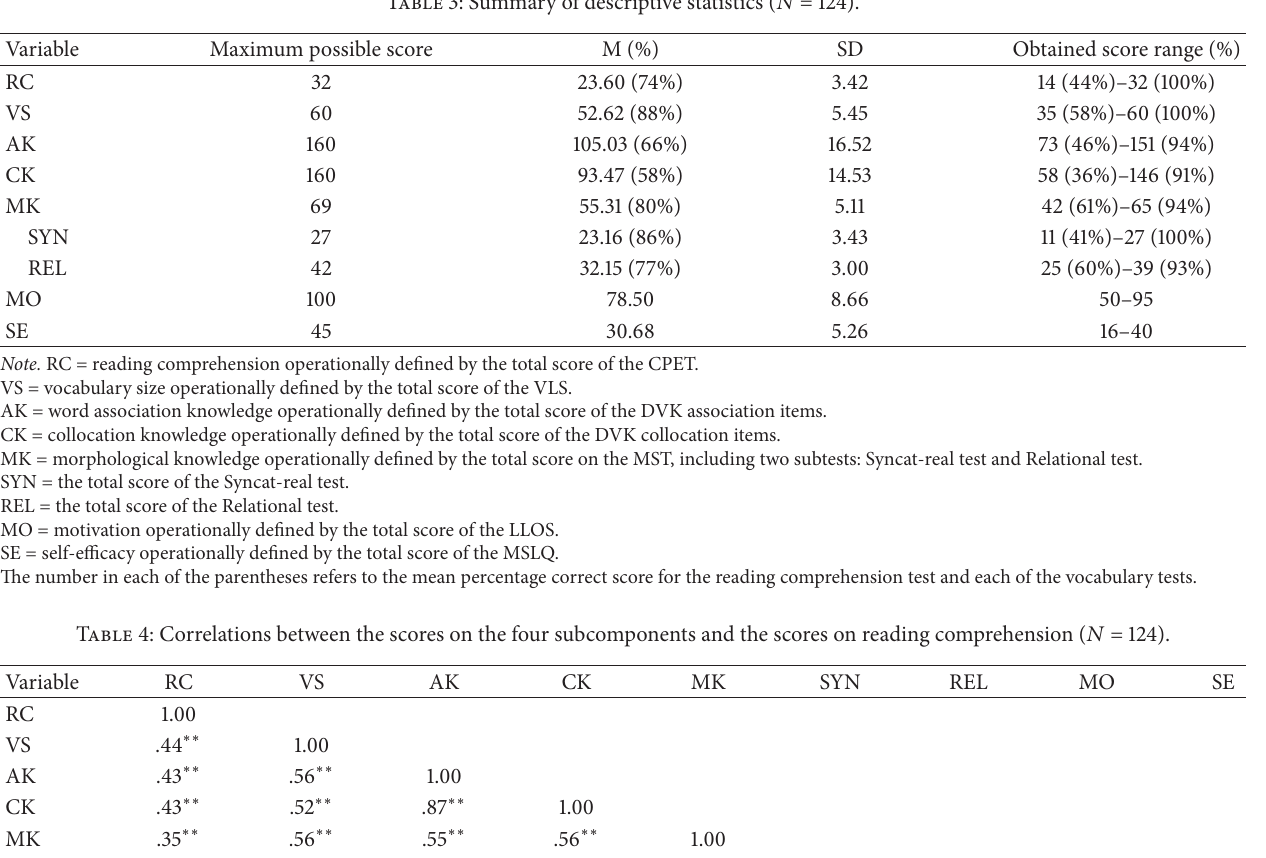
Table 3: Summary of descriptive statistics ( 𝑁 = 124).